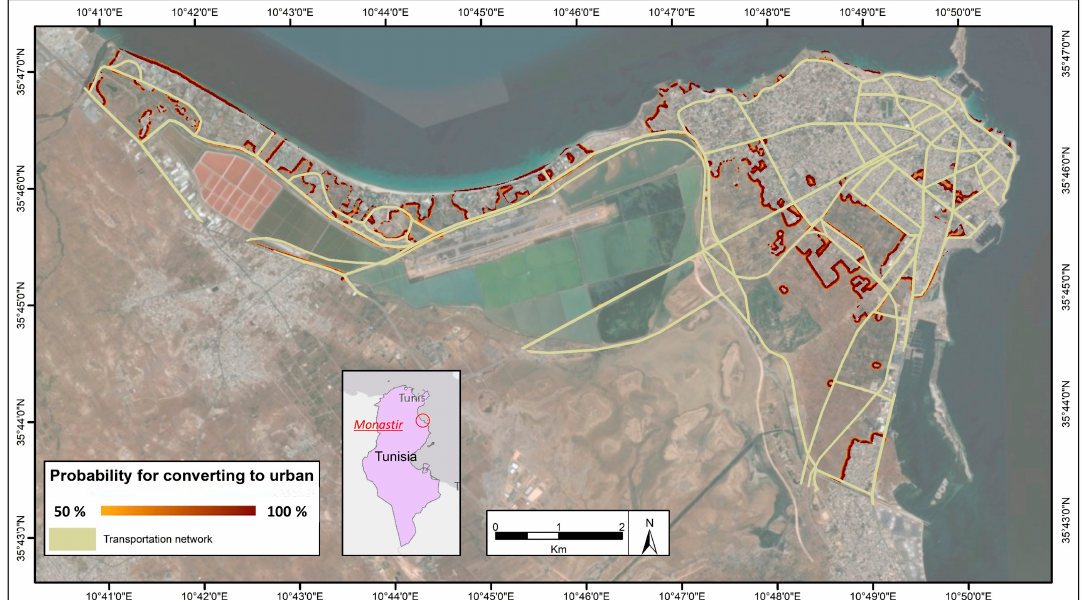
Figure 6. Probabilistic layer for urban growth in the peri-urban areas under the BaU simulation.